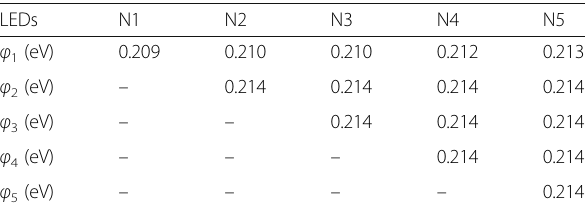
Table 4 Conduction band barrier heights of each NPN-AlGaN junction for LEDs N i ( i = 1, 2, 3, 4, and 5)